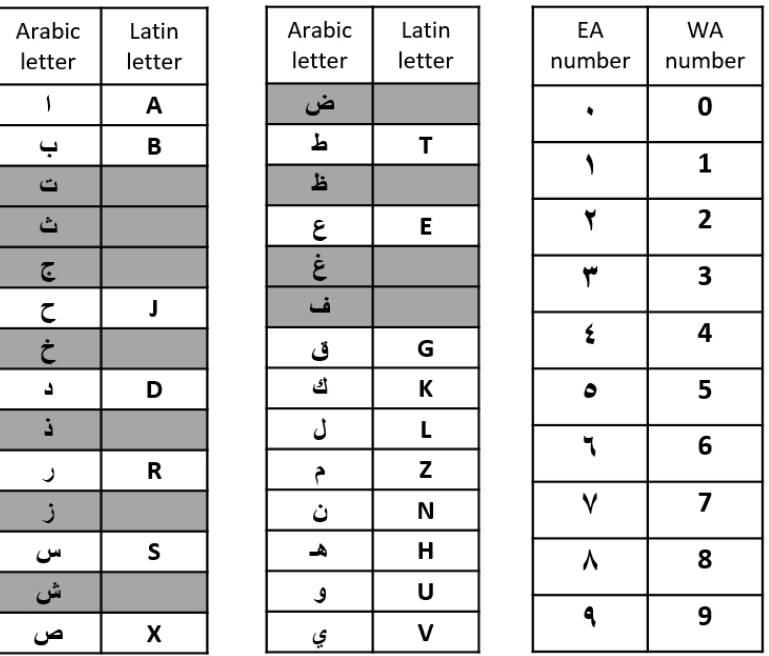
Figure 3. Correspondence between Arabic and Latin letters, and between Eastern Arabic (EA) and Western Arabic (WA) digits in Saudi license plates. Letters that are not allowed on Saudi license plates are shown on a gray